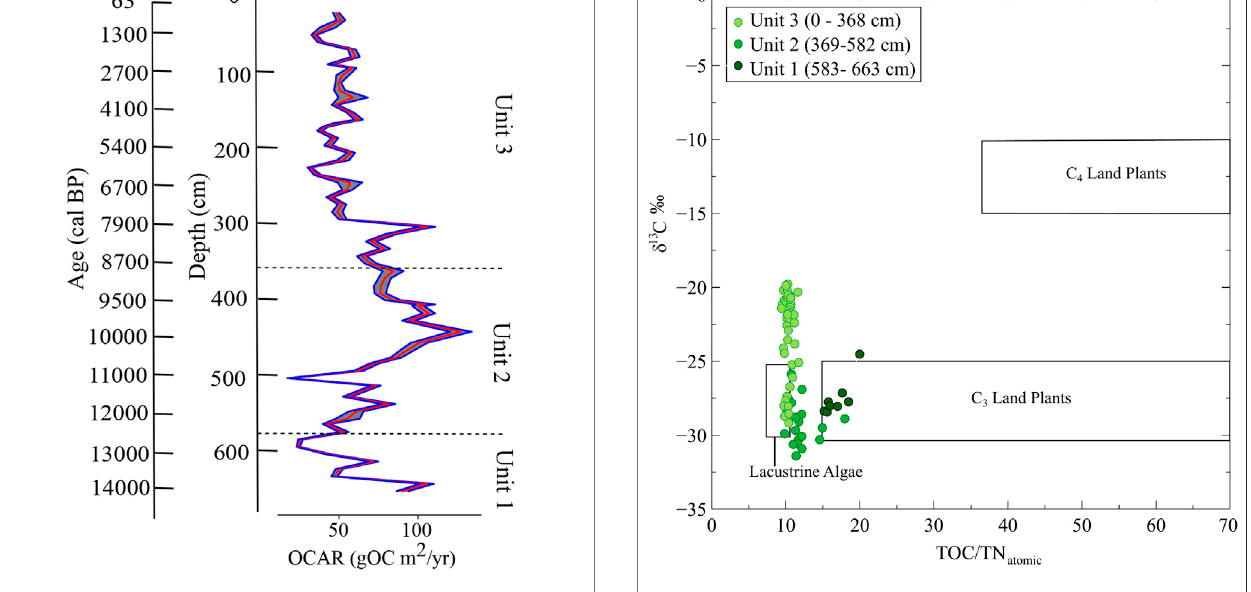
FIGURE 5 | Organic carbon accumulation rate (OCAR, in g OC m − 2 a − 1 ) for each biogeochemical subsample along the core (see Figure 4 ), inferred from the age-depth model, as well as sedimentation and mass accumulation rates (see Figure 2 ).